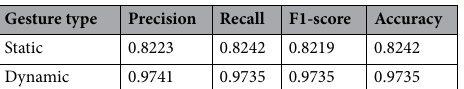
Table 3. Overall metrics of the static and dynamic signs using the proposed